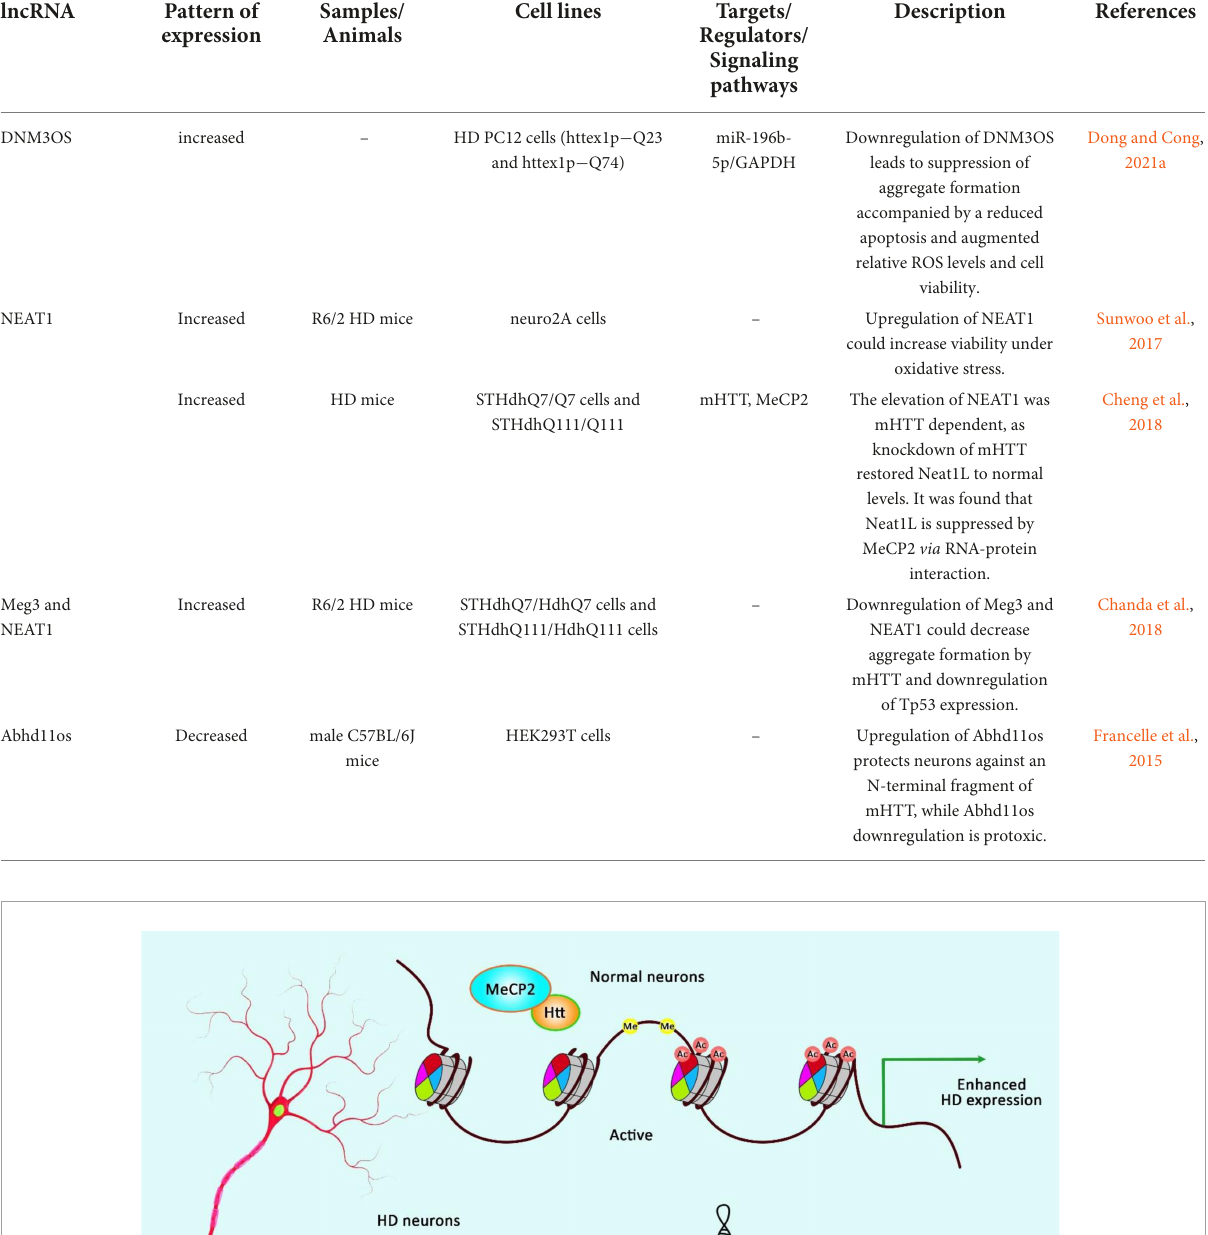
TABLE 2 Long non-coding RNAs and Huntington’s disease (HD, Huntington’s disease; mHTT, mutant Huntingtin). lncRNA